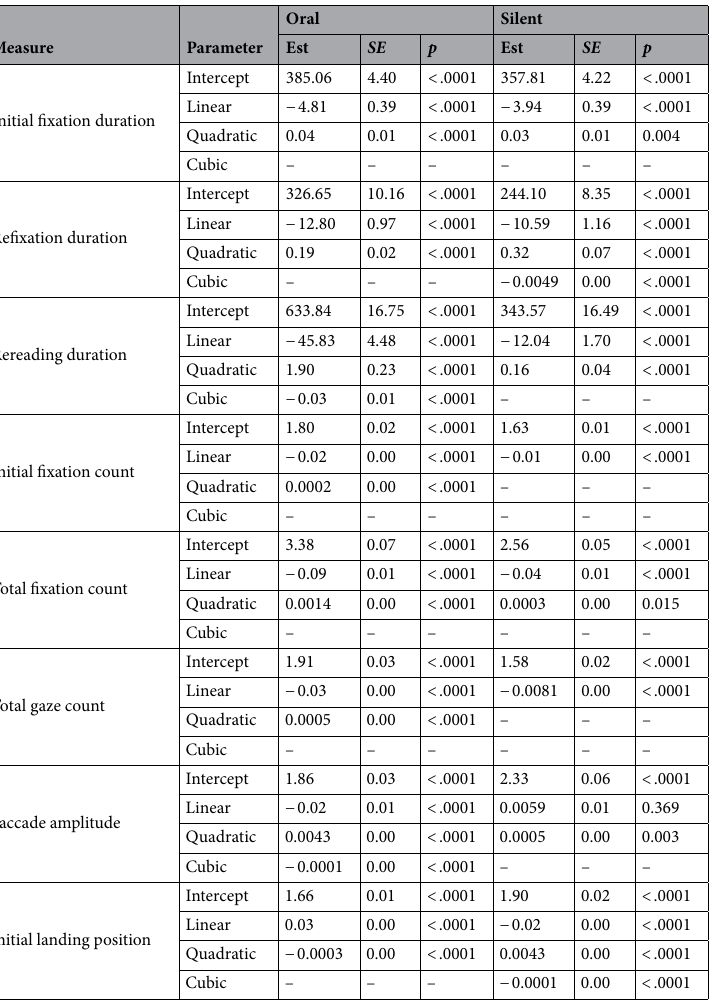
Table 5. Fixed effect coefficients for random effects growth models by oral and silent reading